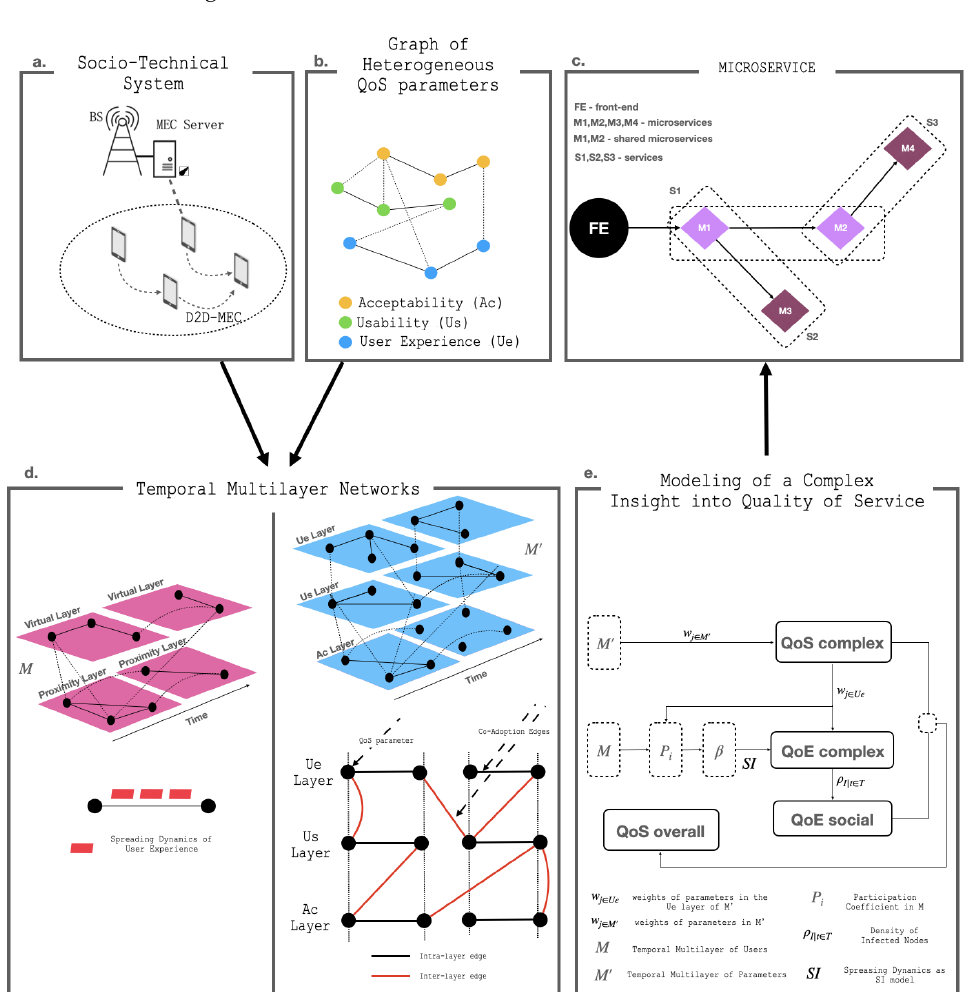
Figure 1. Bringing complexity to 6G to assess the quality of microservices. The figure schematically describes the main aspects of our proposed modeling approach. We consider a socio-technical system of mobile users and devices ( a ) exploiting a D2D-MEC system for communication and computing of tasks. We assume that a set of services accessed by end users, as in ( a ), is represented as a set of microservice applications which consists of multiple composite services ( c ). We consider a graph of heterogenous networked QoS parameters ( b ), belonging to different categories (Ac, Us, Ue). In ( d ), we show the temporal multilayer representation for both environments. The analysis of both complex structures, their interdependence and dynamics leads to the complex systems of QoS and QoE, whose algorithm is detailed in the scheme in ( e